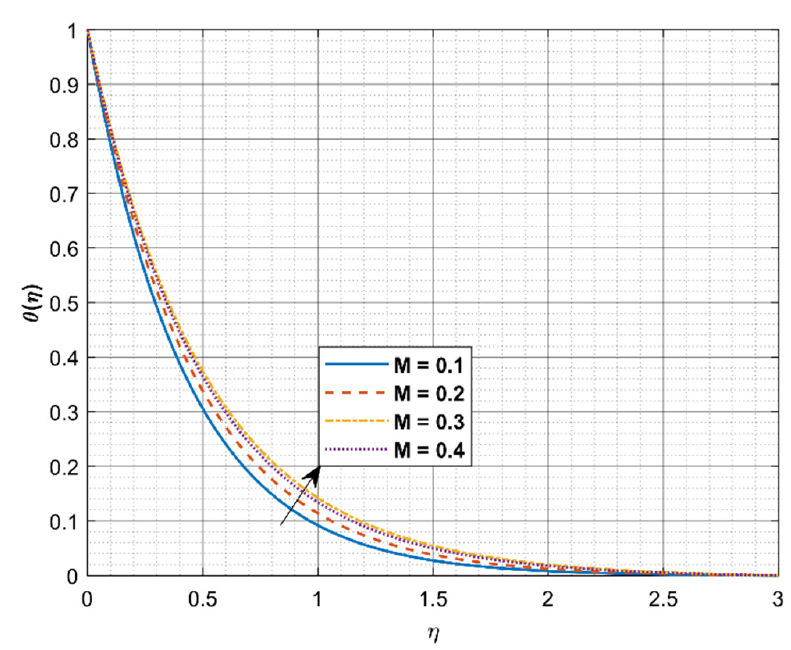
θη θη . Figure 3. Influence of M on θ ( η ) .